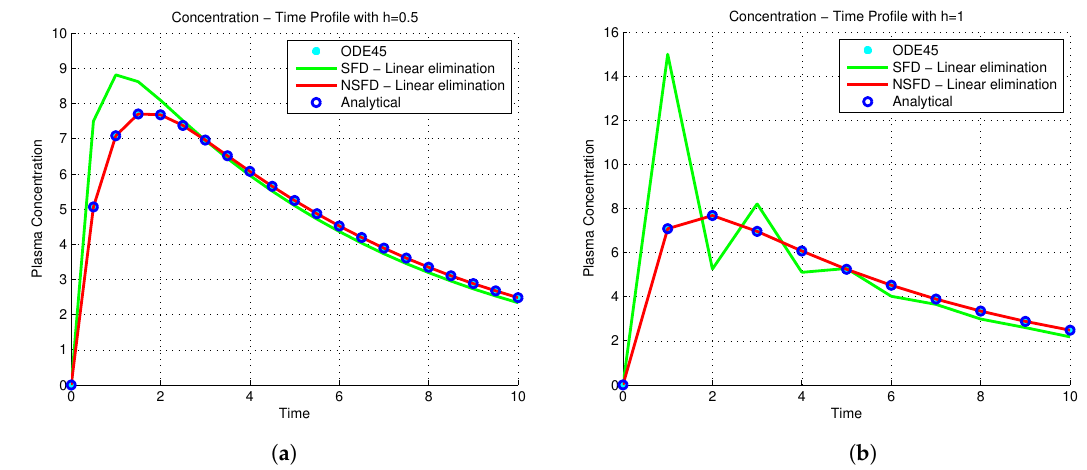
Figure 11. NSFD scheme (76), SFD scheme (78) and ODE45 is compared with exact solution (57). Plasma concentration-time curve for a drug given as a single oral dose with linear pharmacokinetic elimination ( a ) h = 0.5 and ( b ) h = 1.